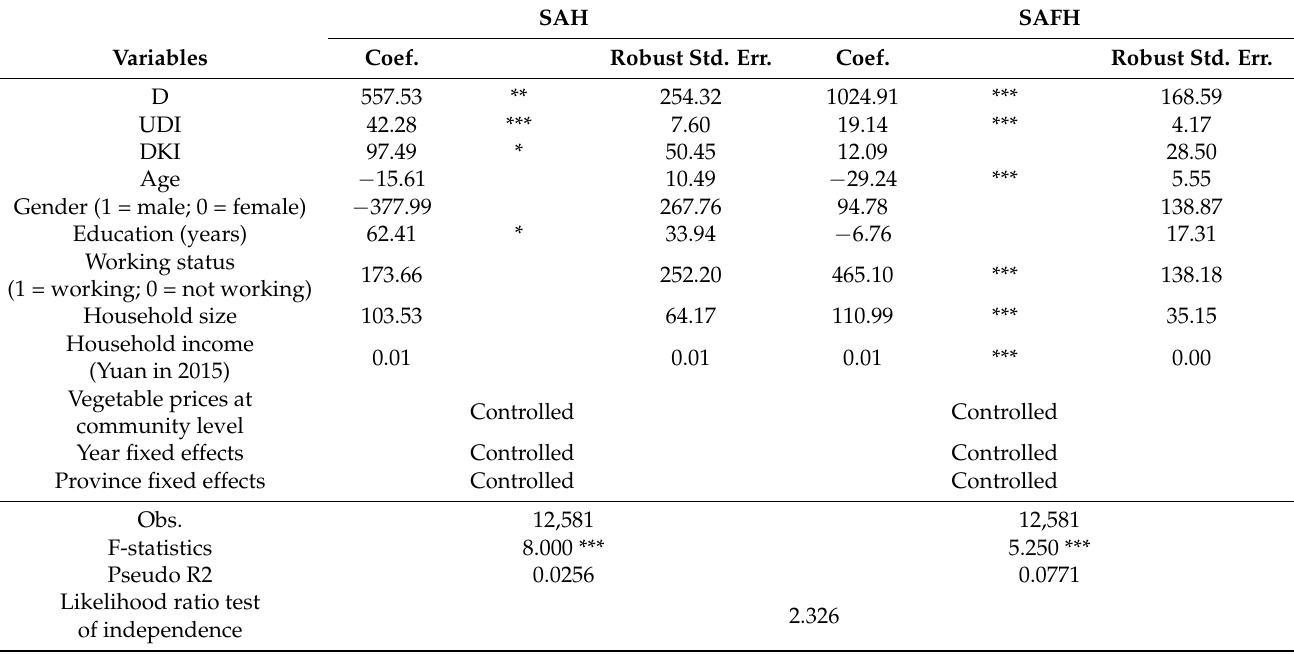
Table 5. Estimation results on SAH and